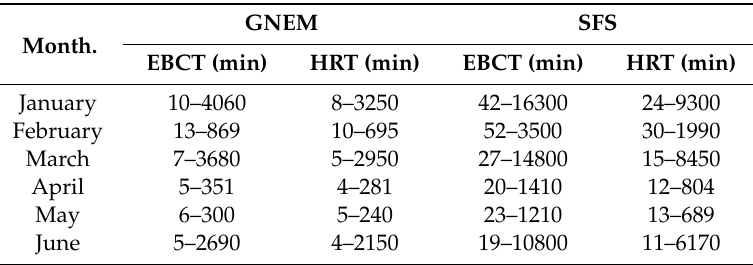
Table 8. The minimum and maximum EBCT and HRT for the GNEM and SFS media for the study site.